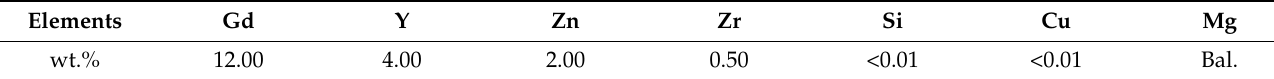
Table 1. The chemical composition of Mg-12Gd-4Y-2Zn-0.5Zr alloy.